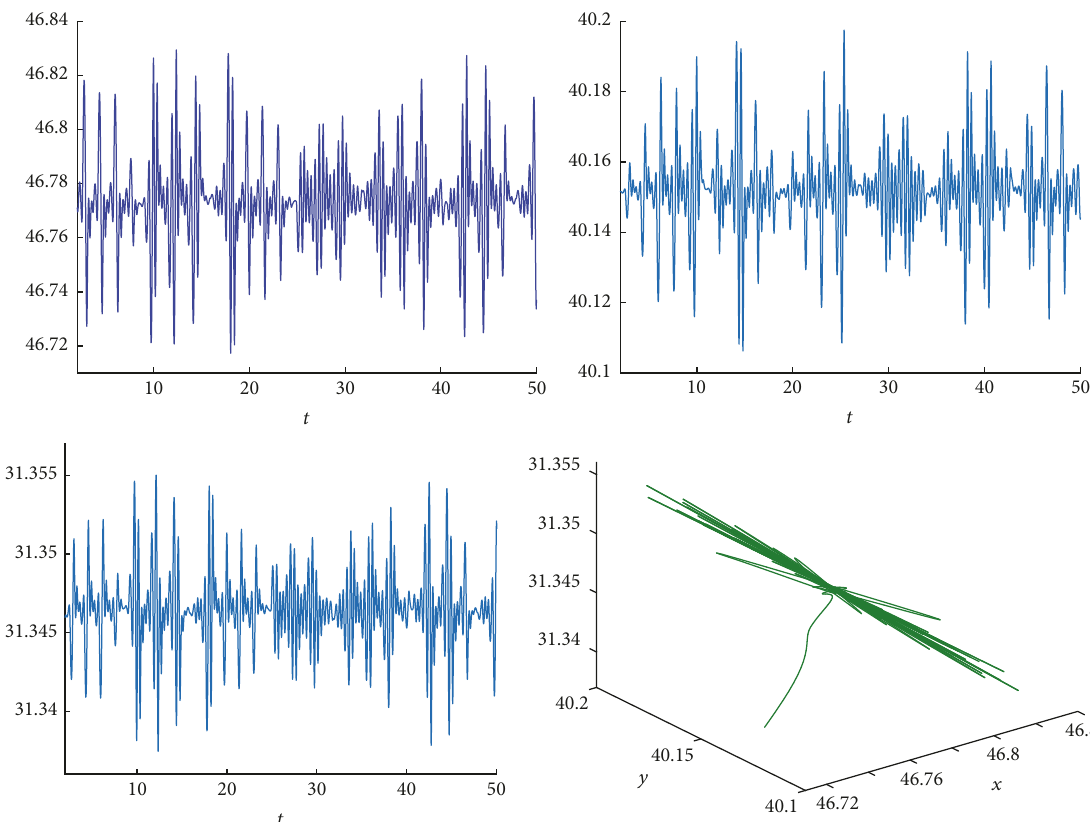
Figure 7: Dynamical behaviors and phase space trajectories of the three fish